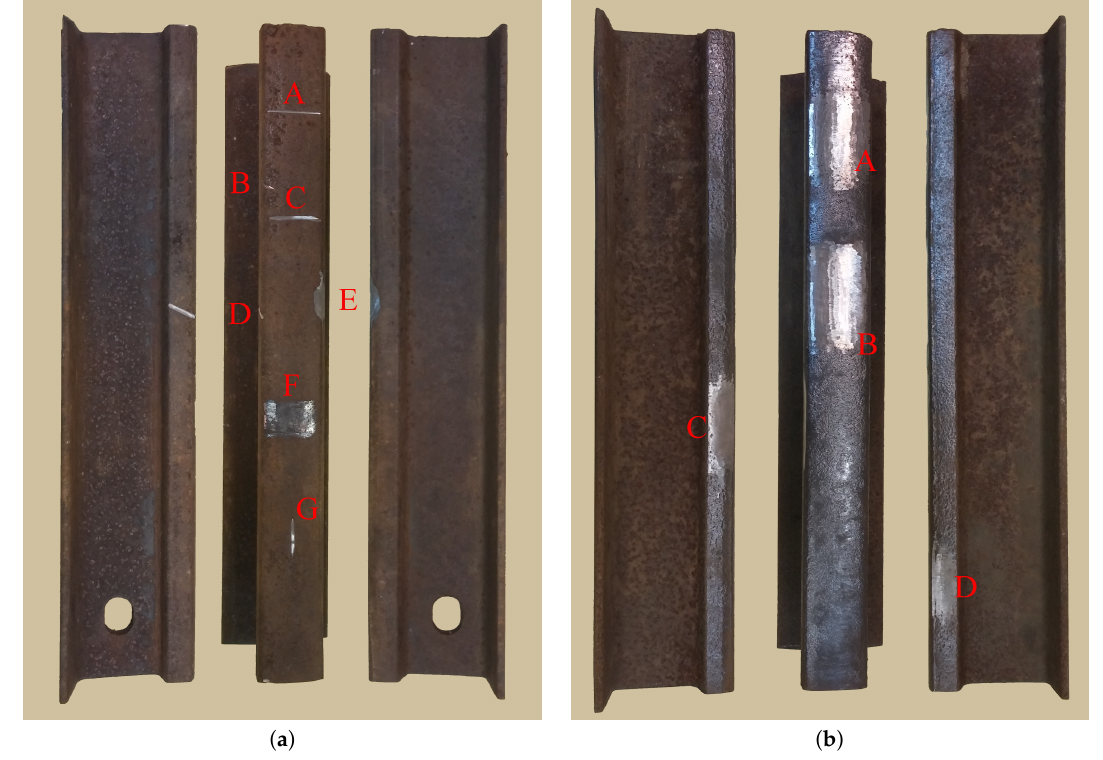
Figure 3. Rail fragments used in experiments: ( a ) rail fragment #1; ( b ) rail fragment #2. Table 1. Dimensions of defects on rail fragments #1 and